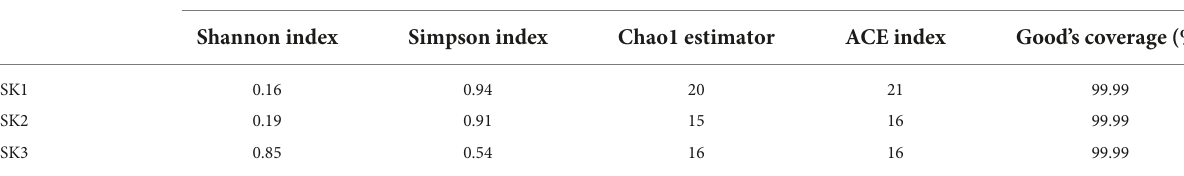
TABLE 1 Microbial richness and alpha-diversity indices of the